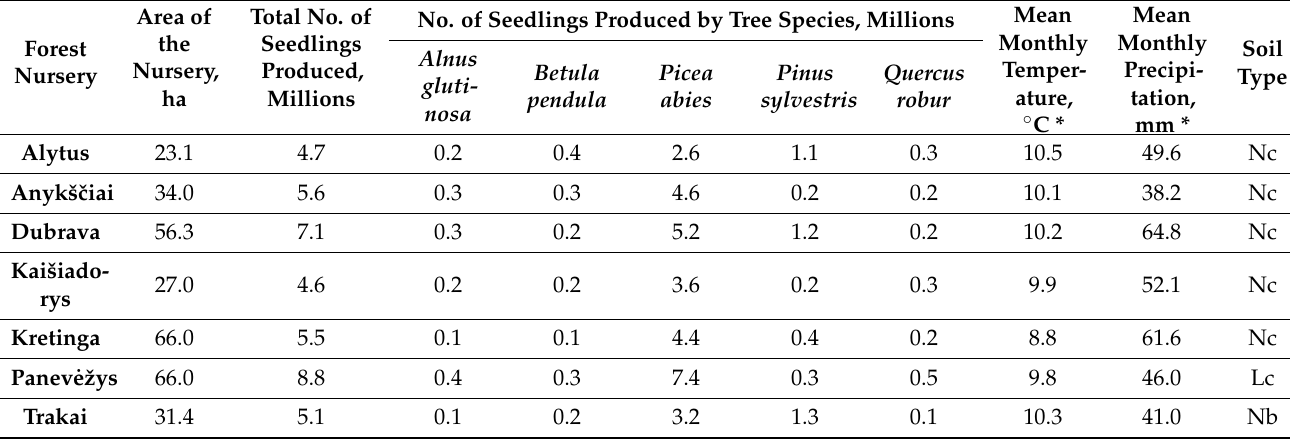
Table 1. Characteristics of the seven largest bare-root forest nurseries in Lithuania that were sampled in the present study. Area of Forest Nursery